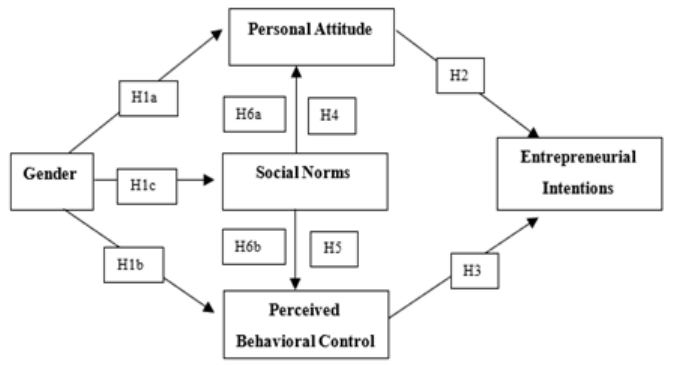
Figure 1. Structural model and hypotheses.